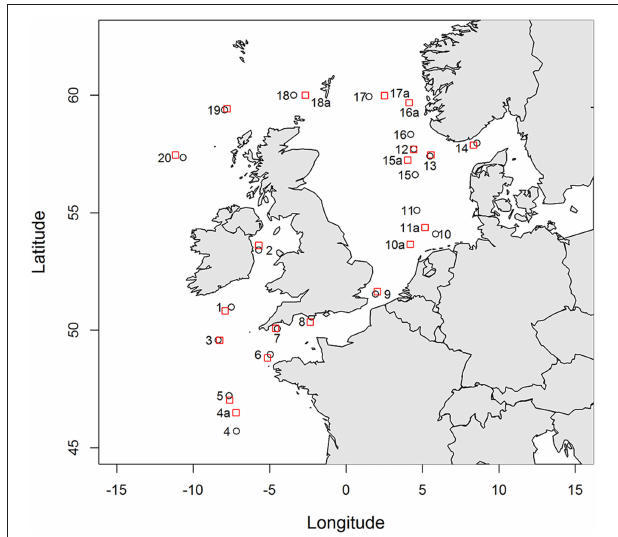
FIGURE 1 | Locations sampled from the CTD cast (red squares) and from the underway sampling system (black circles). Where stations are not directly adjacent, underway samples are labeled with the station number and the letter